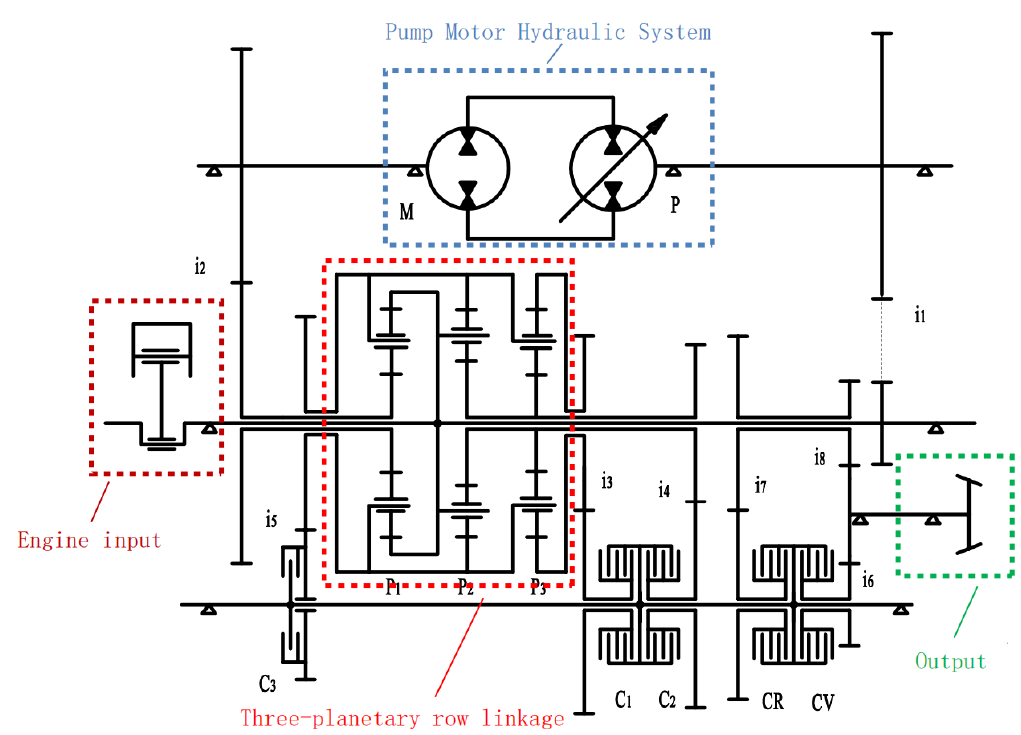
Figure 1. Principle diagram of three-planetary-row HMCVT scheme.